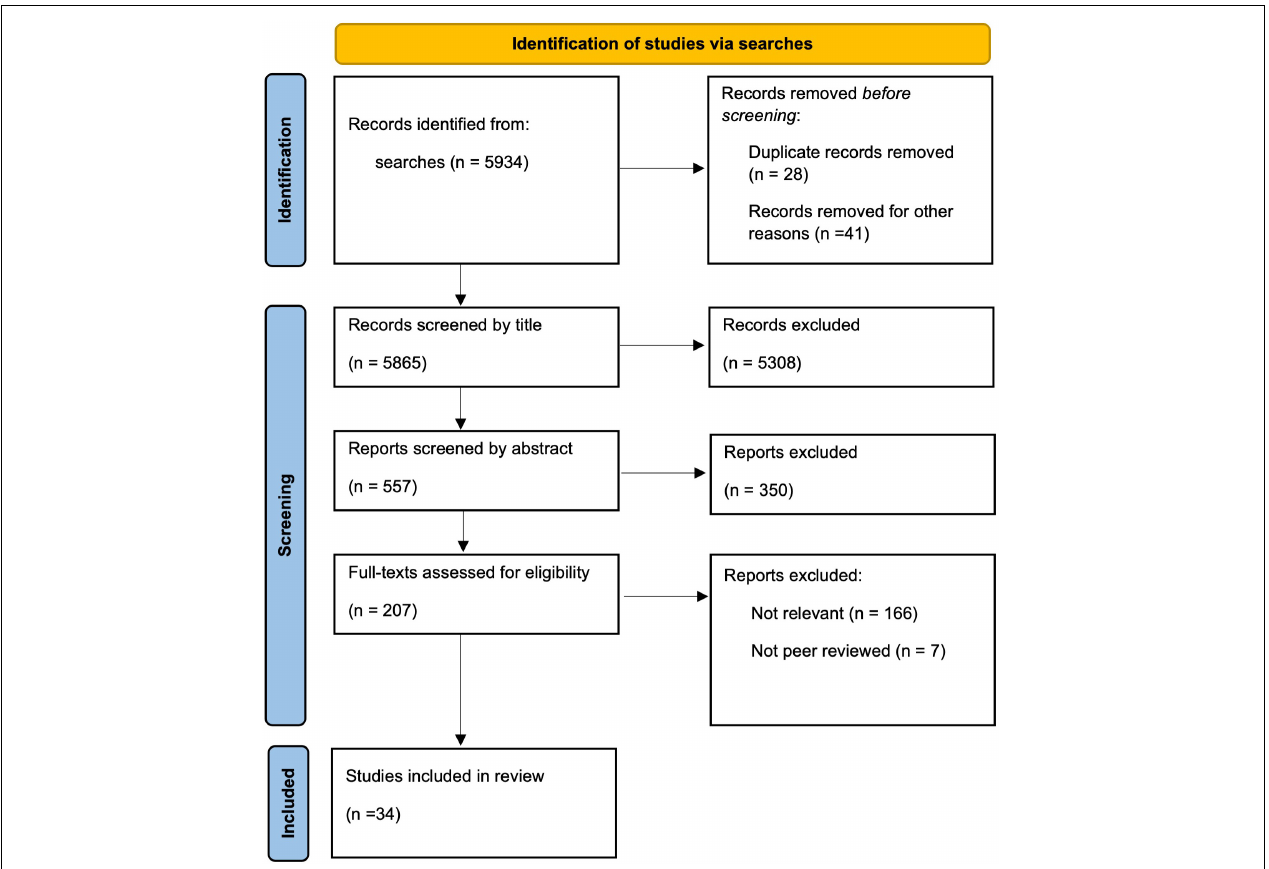
FIGURE 1 | PRISMA flow diagram for the scoping review process goes